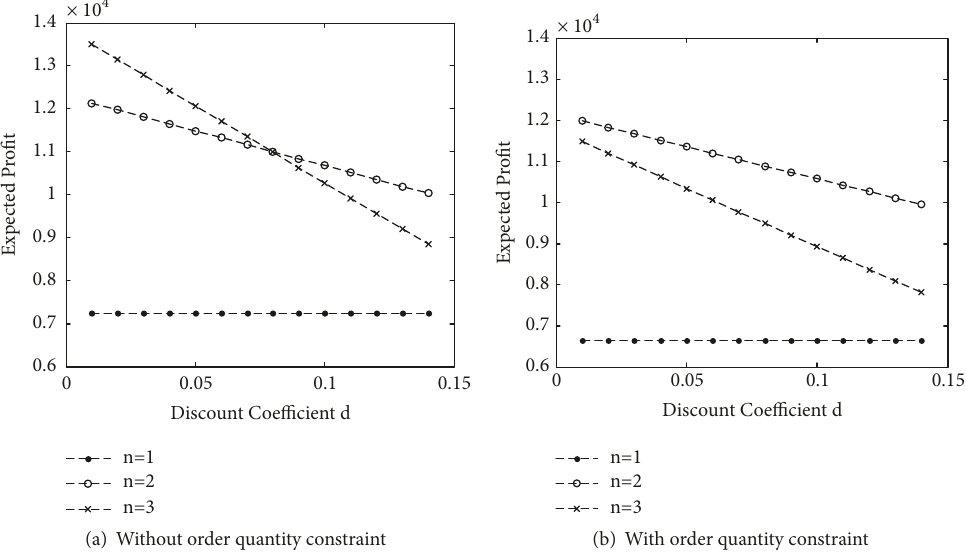
Figure 4: Effect of discount coefficient on the retailer’s expected